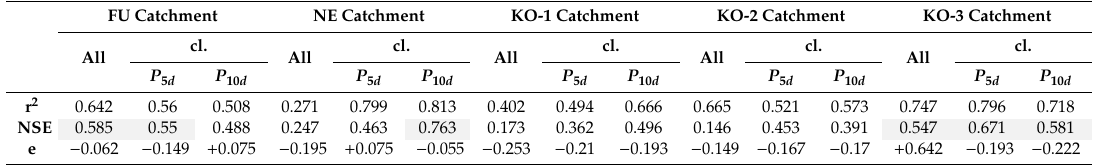
Table 10. Accuracy of direct runo ff simulations using pairs of S and λ identified by means of model fitting procedure. NSE ≥ 0.500 indicating su ffi cient accuracy are